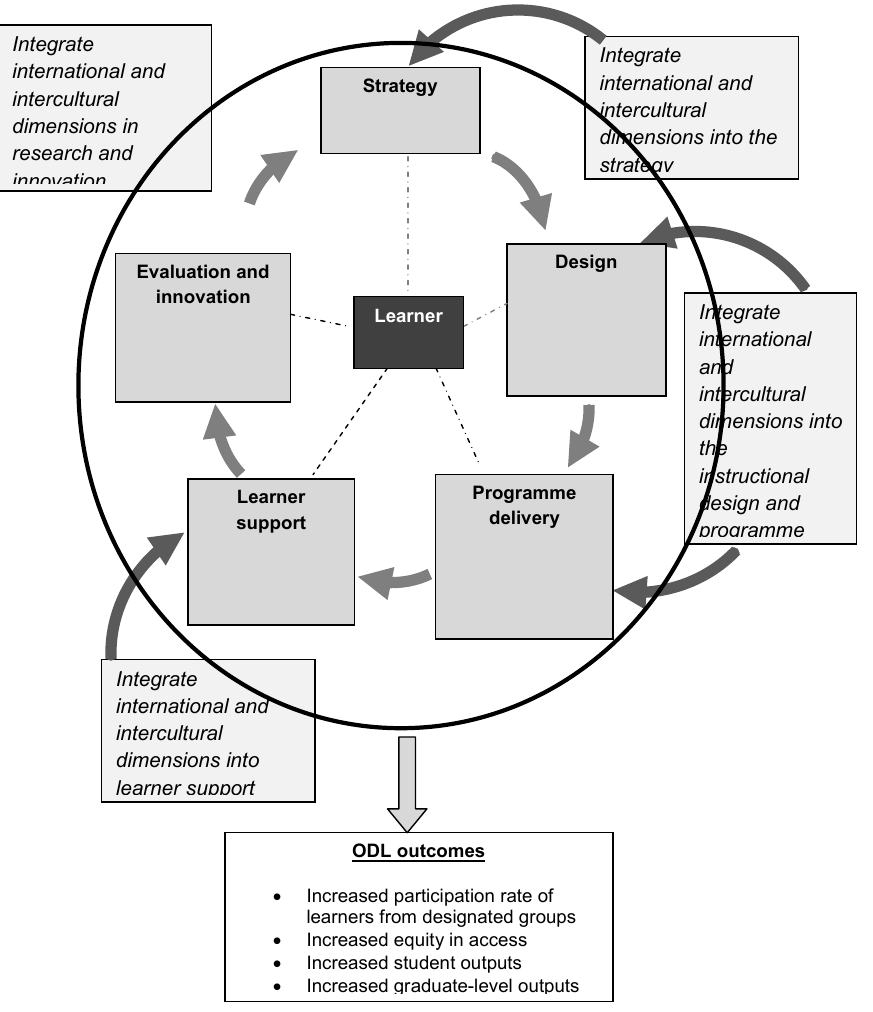
Figure 4 . Illustrating the interplay between ODL and